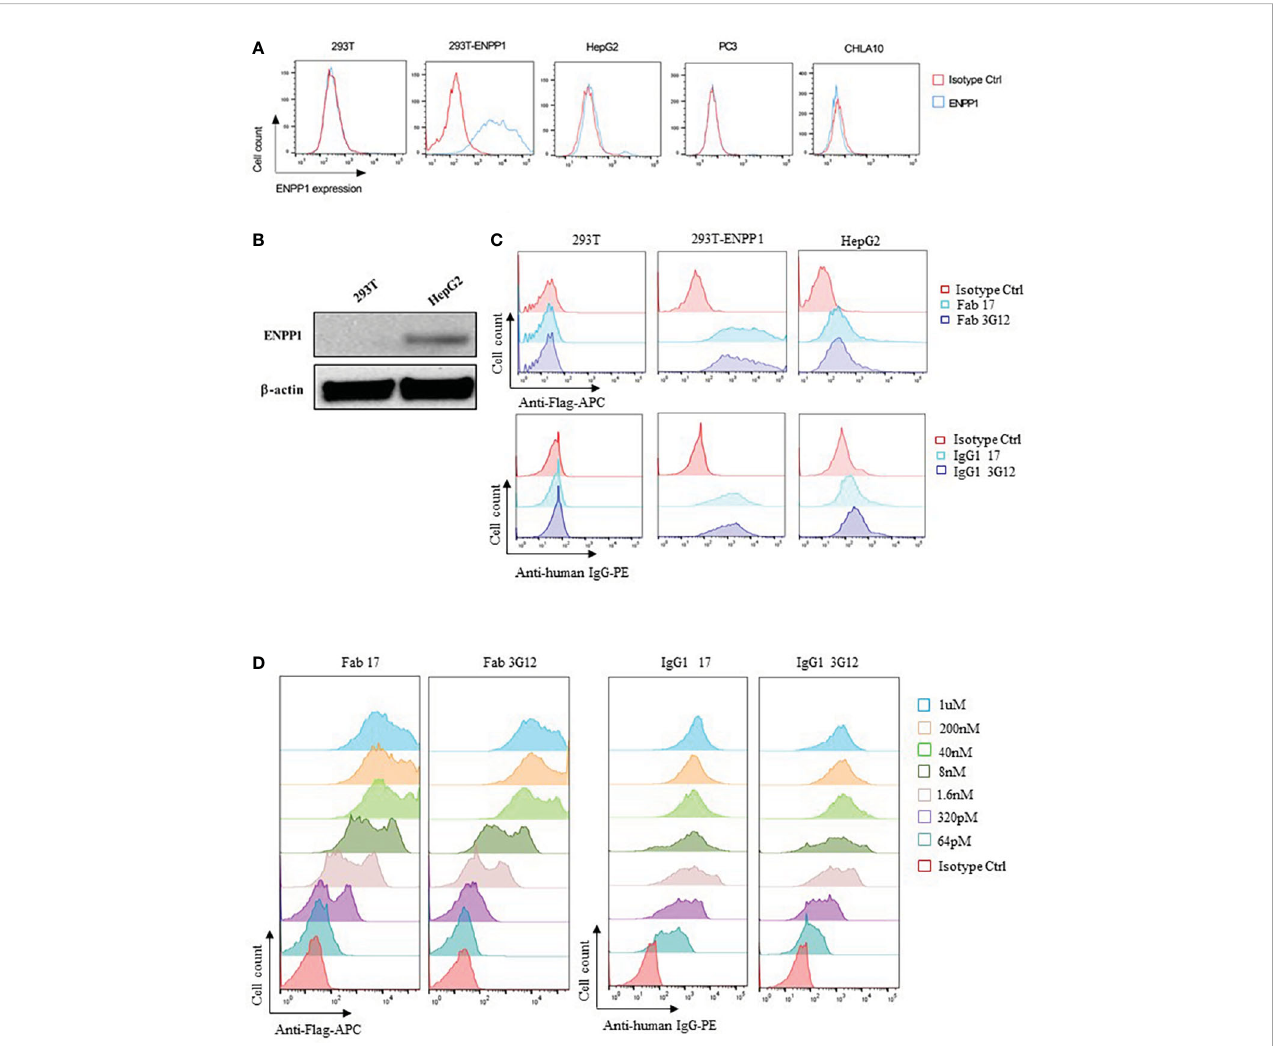
FIGURE 2 Speci fi city of Fab/IgG1 with human ENPP1 on cell surface (A) , Detection of ENPP1 cell surface expression level on 293T, 293T-ENPP1, HepG2, PC3, and CHLA10 cell lines by a commercial rabbit anti-human ENPP1 antibody followed by an anti-rabbit IgG-AF488 secondary antibody from Abcam. (B) , Veri fi cation of ENPP1 expression on 293T and HepG2 cells by Western Blot. (C) , Cell surface binding of Fab 17 and 3G12 (1uM), IgG1 17 and 3G12 (100nM) on 293T, 293T-ENPP1 and HepG2 cells. (D) , Dose-dependent cell surface binding of Fab 17 and 3G12, IgG1 17 and 3G12 on 293T-ENPP1